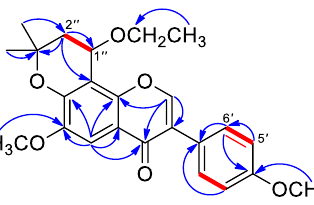
Figure 2. Key COSY (red bold line) and HMBC (blue arrow) correlations of 1